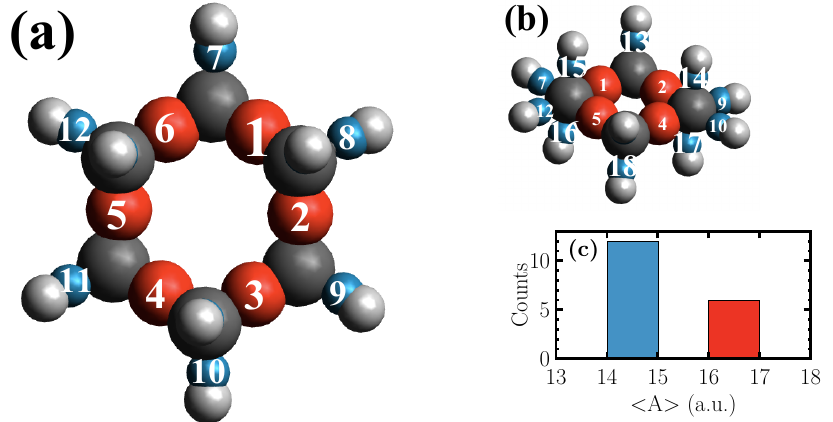
Figure 2. Atomic configuration of a cyclohexane molecule in its chair conformation shown by top ( a ) and side ( b ) views. The carbon and hydrogen atoms are shown as gray and white spheres, respectively. The centers of Wannier functions along C–C (red) and C–H (blue) bonds, are also shown. The radii of the spheres representing the Wannier functions are set according to their corresponding polarizabilities. Eventually, the polarizabilities averaged over all AIMD snapshots of the Wannier functions associated with C–C and C–H bonds are displayed in the inset ( c ).